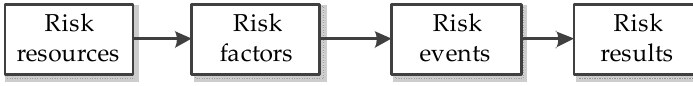
Figure 1. The risk chain structure.